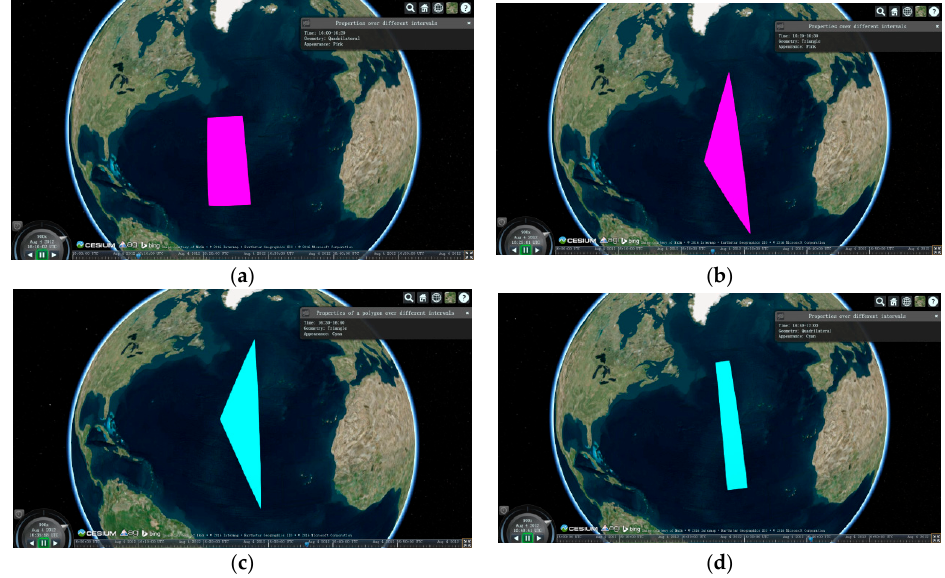
Figure 3. An animated polygon varying over a series of time intervals: ( a ) TimeInterval_1 (from 16:00 to 16:20); ( b ) TimeInterval_2 (from 16:20 to 16:30); ( c ) TimeInterval_3 (from 16:30 to 16:40); and ( d ) TimeInterval_4 (from 16:40 to